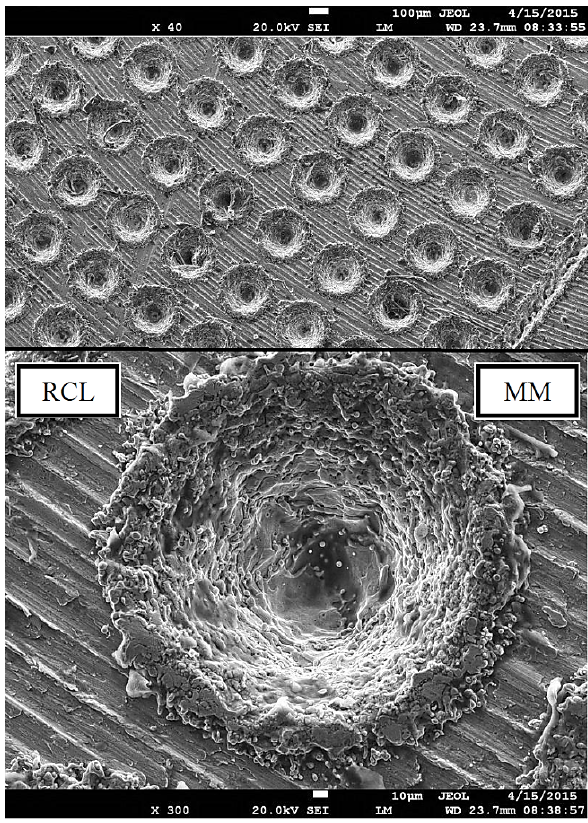
Figure 6: Planar surface of sample I covered by texture